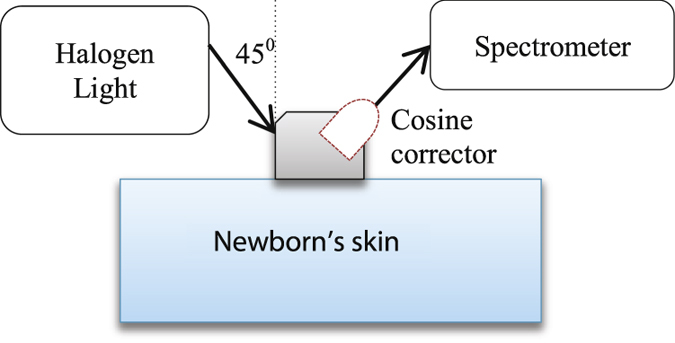
Near-infrared body fat measurement set up.Dotted object is the cosine corrector.